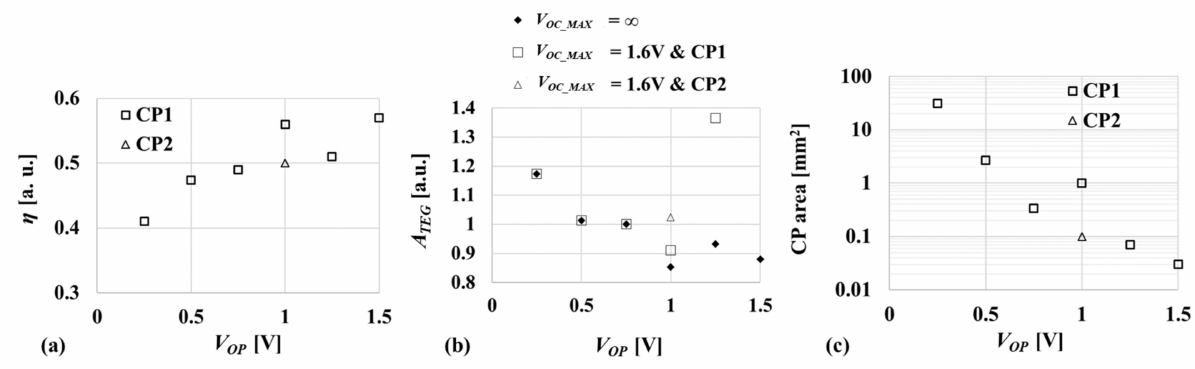
Figure 13. η of CP ( a ), A TEG ( b ) and CP area ( c ) vs. V OP